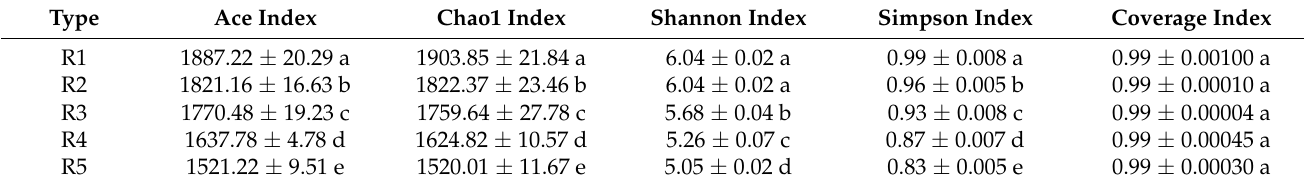
Table 2. Effect of different continuous cropping years on bacterial diversity index of rhizosphere soil in industrial